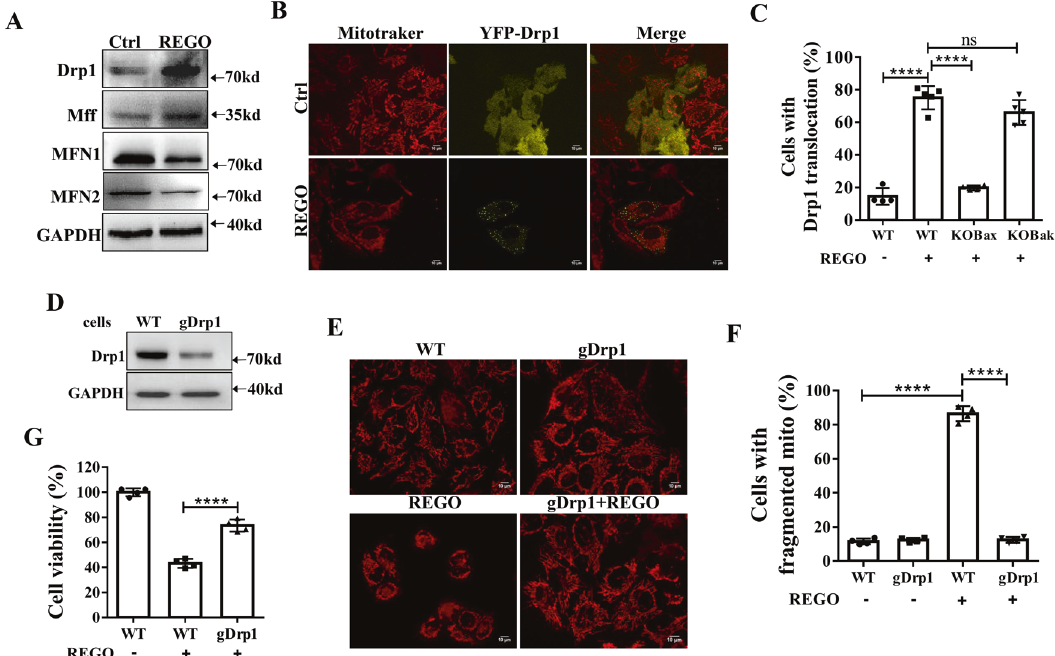
Fig. 5 Bax, but not Bak, recruits Drp1 to mitochondria to mediate REGO-induced mitochondrial fi ssion. A Western blotting analysis on REGO-regulated the expression of mitochondrial fusion and division-related proteins as indicated. B Representative fl uorescence images of cells expressing YFP-Drp1 in the presence or absence of REGO (×600). C Statistical percentage of cells with mitochondrial Drp1. D Western blotting analysis con fi rmed CRISPR/Cas9-mediated knockout of Drp1. E Representative fl uorescence images of intracellular mitochondrial morphology of WT and gDrp1 in the presence or absence of REGO (×600). F Statistical percentage of cells with fragmented mitochondria. G Drp1 was required for REGO-induced cytotoxicity measured by CCK-8 assay. N ≥ 50 cells. **** p < 0.0001, ns (no signi fi cant) p > 0.05.